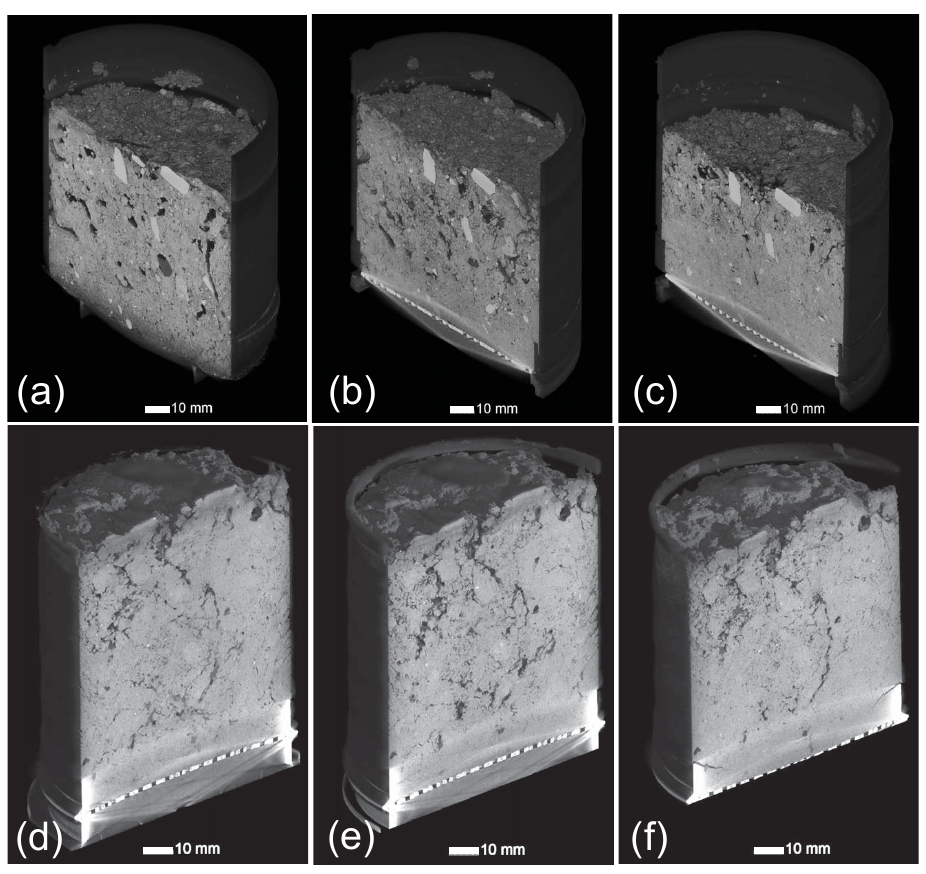
Figure 2. X-ray microtomography images of the soil structure in the Köllme soil (a) at full water saturation ( ψ = 0kPa) and (b) at ψ = − 100kPa and (c) at ψ = − 500kPa and in the Bad Lauchstädt soil (d) at full water saturation ( ψ = 0kPa) and (e) at ψ = − 50kPa and (f) at ψ = − 300kPa.